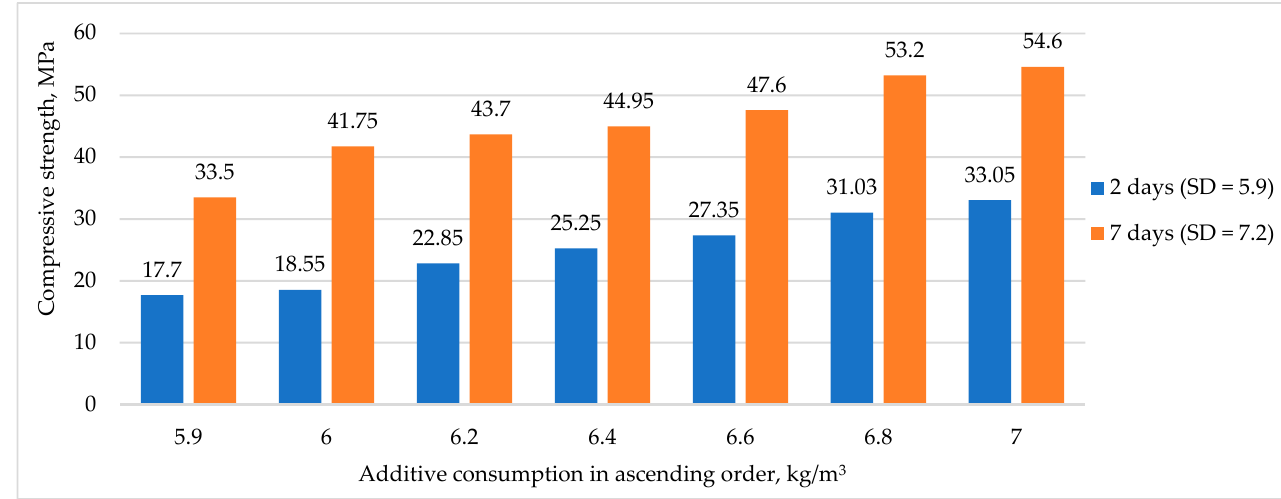
Figure 7. The e ff ect of PCE hyperplasticizer amount on RHC strength gain. Figure 7. The effect of PCE hyperplasticizer amount on RHC strength gain.